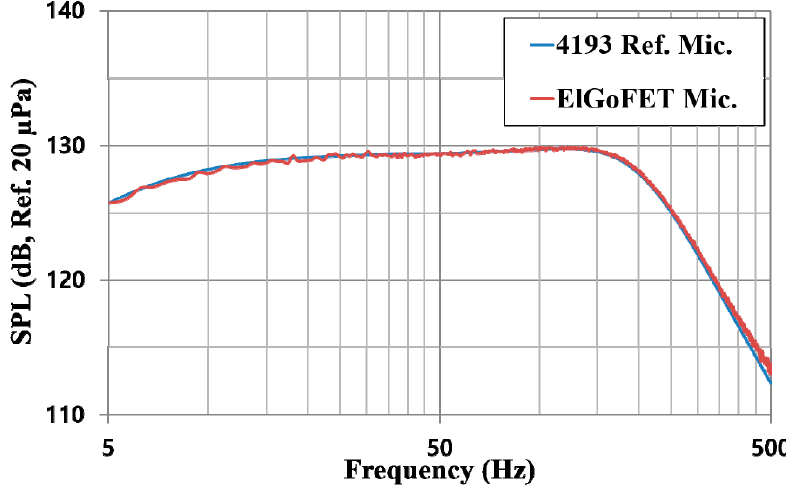
Figure 11. Sound pressure level (SPL) measured using the ElGoFET microphone (red line) and the B&K 4193 reference microphone (blue line).